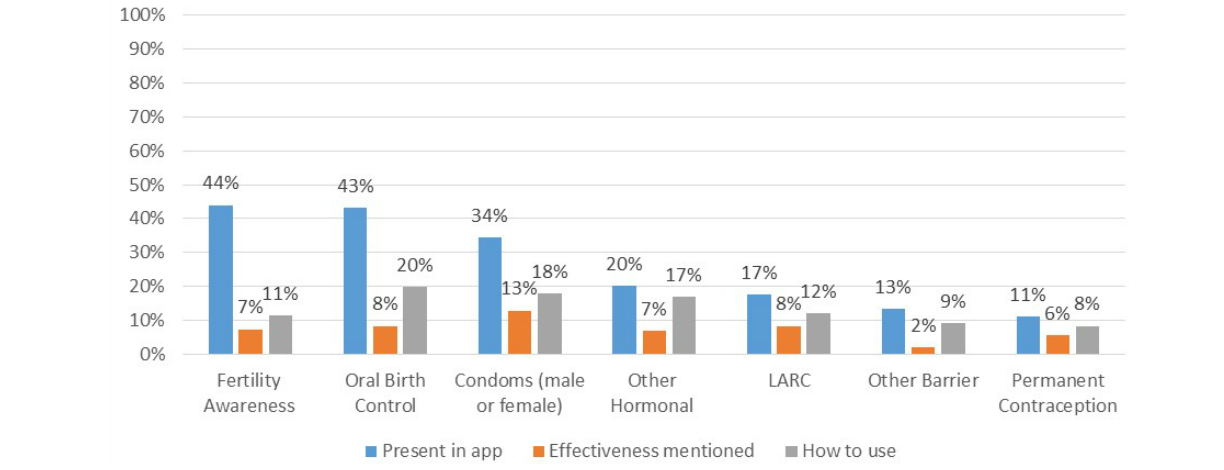
Figure 4. Percentage of mobile phone apps containing information about types of contraceptive methods, their effectiveness, and